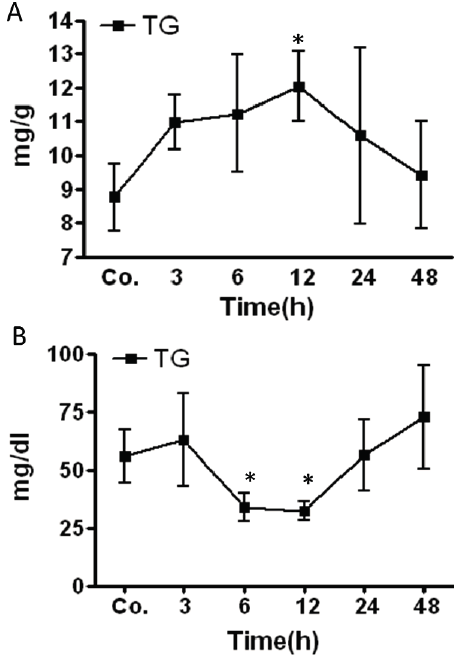
Figure 2. Changes in triglyceride (TG) concentrations in liver tissue lysate ( A ) and serum ( B ) of irradiated mice compared to the sham-irradiated controls for each time point. Results represent mean value ± S.E.M. of five animals * p < 0.05